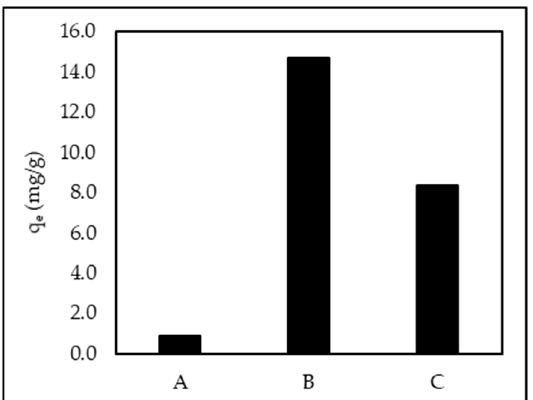
Figure 2. Comparison of adsorption capacity between ZL–CH hydrogel and absence of chitosan. ( A ) Original zeolite, ( B ) chitosan dissolved with 1% acetic acid (AA), ( C ) chitosan dissolved with 3% acetic acid (AA) (ZL–CH hydrogel 30 mg, 100 mL of 10 mg/L AR88, Original pH of AR88 (6.5), contact time 15 min).